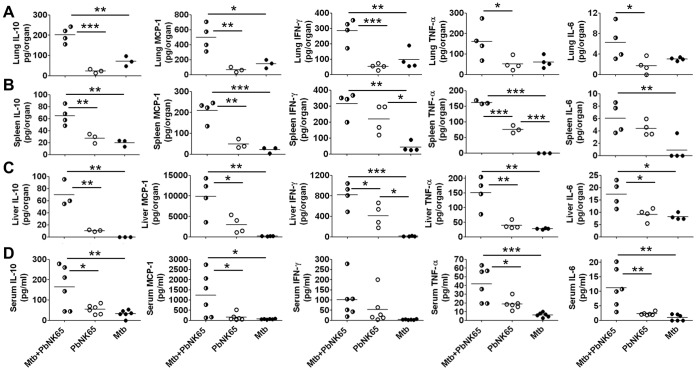
Co-infection with M. tuberculosis and PbNK65 induces a cytokine storm.C57BL/6 mice were infected by aerosol with M. tuberculosis H37Rv (100 CFU/lung) and challenged with PbNK65 sporozoites by mosquito bite 40 days later. Control mice were infected with M. tuberculosis or PbNK65 alone, respectively. Cytokine levels were measured in lungs (A), spleens (B), livers (C) and sera (D) 13–14 days after co-infection. Statistical analysis was performed by ANOVA and Tukey’s Multiple Comparison test. (*p<0.05; **p<0.01; ***p<0.001). Data from one out of two independent experiments are shown.